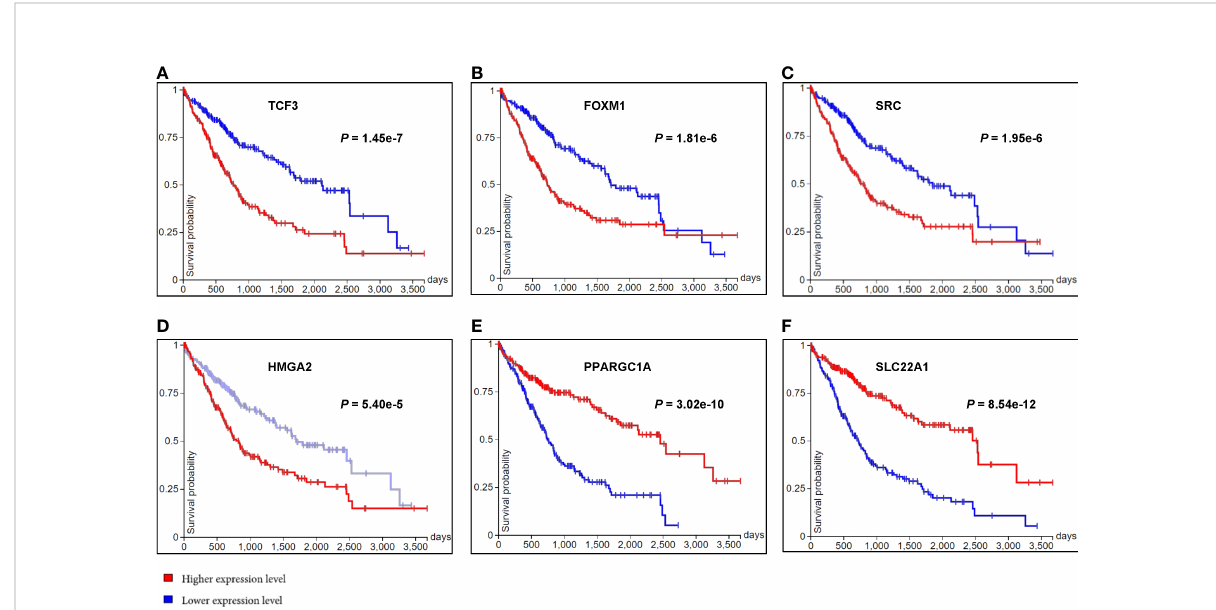
FIGURE 5 Kaplan-Meier plots of the overall survival of HCC patients between higher and lower gene expression levels of six differentially expressed genes observed in HCN-NOS. The horizontal axis represented the overall survival time in days and the vertical axis represented overall survival probability. Higher gene expression levels of TCF3 (A) , FOXM1 (B) , SRC (C) and HMGA2 (D) were all associated with lower overall survival while higher gene expression levels of PPARGC1A (E) and SLC22A1 (F) were associated with higher overall survival of HCC